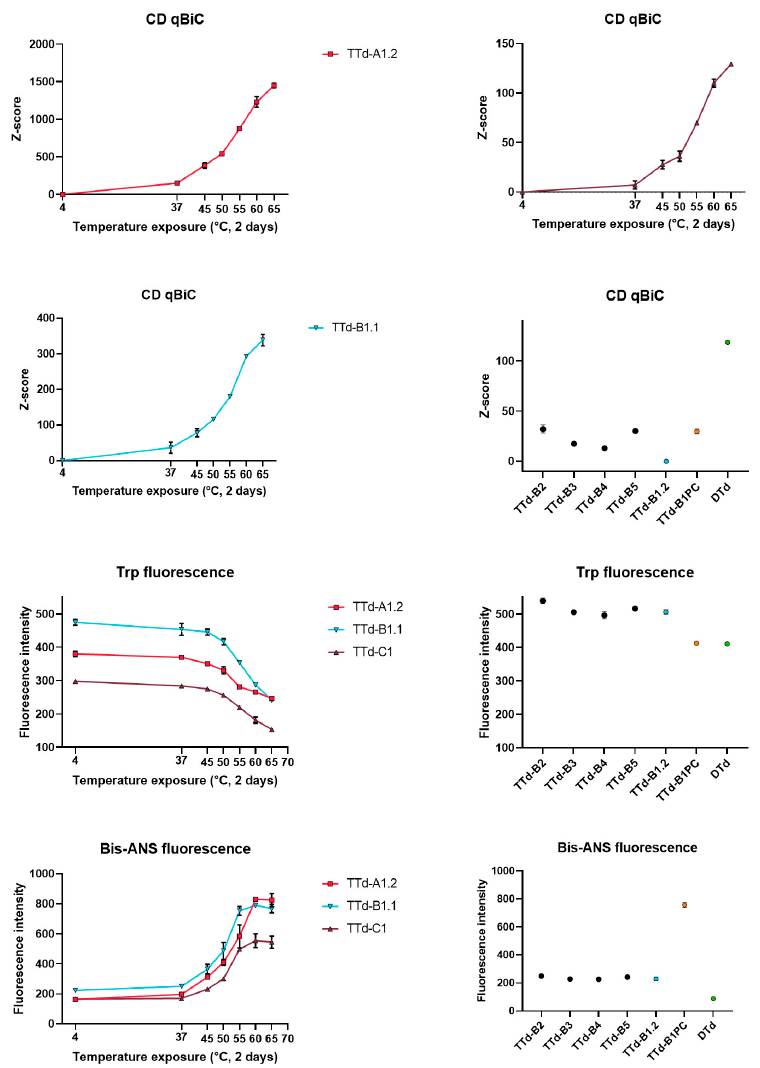
Figure 6. Evaluation of protein folding by circular dichroism (CD), tryptophan fluorescence and Bis-ANS fluorescence. CD spectra were analyzed using qBiC to compare di ff erences in higher order structure. Error bars represent the SD of three aliquots of the same batch.